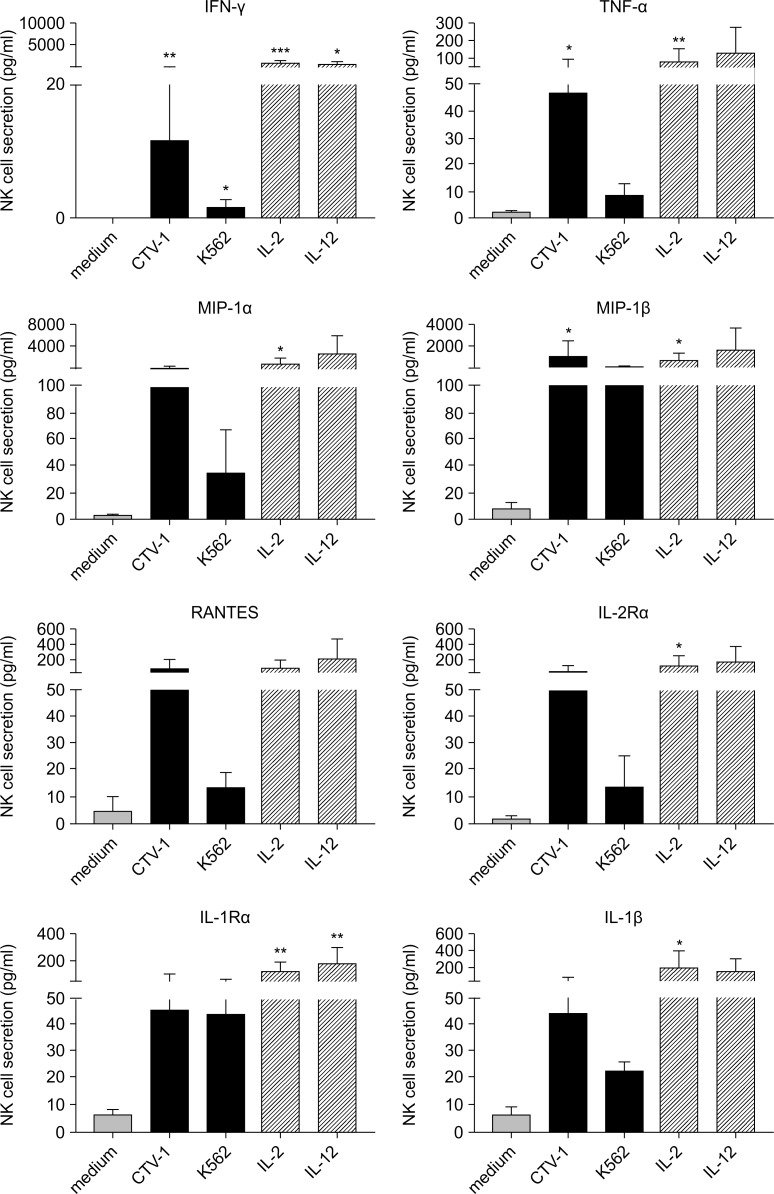
Influence of tumor- or cytokine-priming on cytokine secretion by NK cells.NK cells were incubated in medium alone, with K562, or CTV-1 cells for 6 hours or with IL-2 or IL-12 overnight at 37°C. Supernatants were harvested, and the concentrations of IFN-γ, TNF-α, MIP-1α, MIP-1β, RANTES, IL-R2α, IL-1α, and IL-1β were determined by a multiplex immunoassay. Bars represent means ± SD of 4 different donors. Post-stimulation NK cell cytokine secretion was compared with that in cells incubated in medium alone using the paired t-test. Statistical significance is indicated as: *P <0.05; **P <0.01; ***P <0.001.